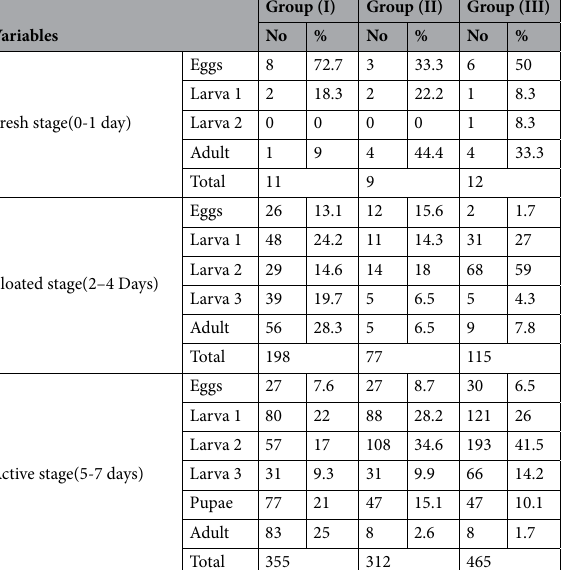
Table 1. Comparison between the studied groups in Arthropods of Forensic during 0-7